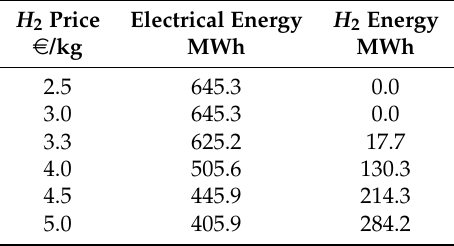
Figure 6. Hourly diagram of hydrogen produced, in kg/h, by the electrolyser at the selling hydrogen price of 4.2 e /kg. Table 4. Daily energy sold under the form of electricity and